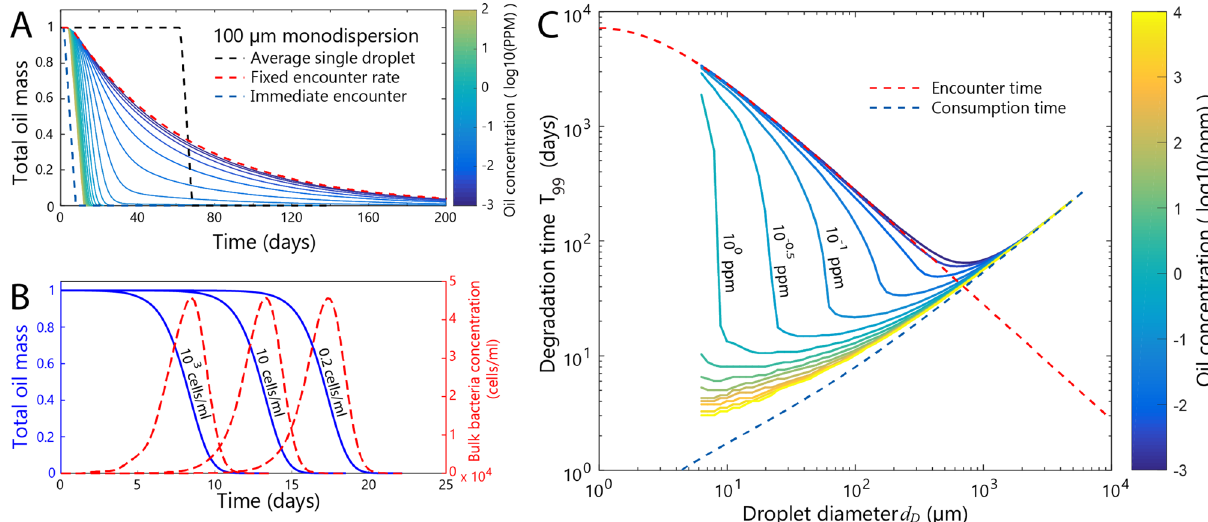
Figure 3. Degradation of monodispersed oil droplets. (a) The degradation of a single average droplet (black dashed line) overemphasizes the initial lag time and the suddenness of the degradation in comparison to the stochastic degradation of a dispersion of oil droplets. For a given droplet size (here, 100 µm diameter), the initial oil concentration (colormap) determines the extent of enrichment in the bulk bacterial concentration, which influences the overall degradation time. At very low oil concentrations (blue solid lines), the degradation of a monodispersion approaches an exponential decay limit of non-interacting droplets (red dashed line), for which the bulk bacterial concentration remains at its initial value. At high initial oil concentrations (yellow solid lines), the degradation is rapid and linear due to a large increase in bulk bacterial concentration, but delayed relative to the hypothetical case in which all droplets begin in an encountered state (blue dashed line). (b) The time course of the total oil mass for 20 µm diameter droplets at an initial oil concentration of 1 ppm (blue) and the bulk bacterial concentration (red) are given for three initial bacterial concentrations: 10 3 , 10, and 0.2 cells/ml. The initial background bacterial concentration alters the initial lag in the response, but the degradation curves and bacterial concentration profiles remain remarkably similar. (c) Optimal droplet size for the biodegradation of a monodispersion. The time T 99 to degrade a monodispersion of droplets, as a function of the droplets’ diameter, for different initial oil concentrations (colormap). The encounter time (red dashed line) is the time for 99% of the oil droplets to be independently encountered. The consumption time (blue dashed line) is the time it takes for 99% of the mass of a droplet to be degraded after the first encounter